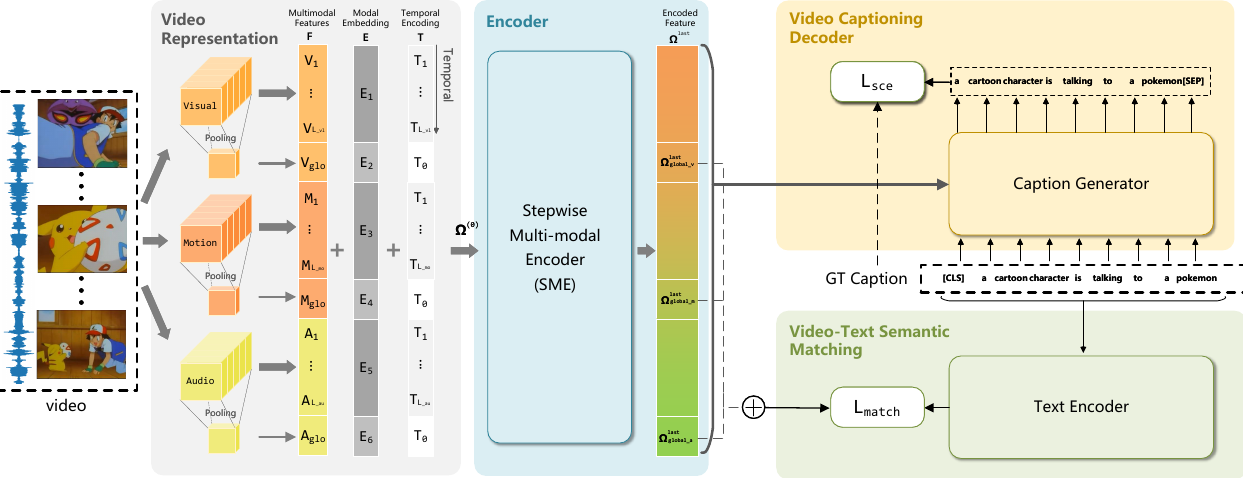
Figure 2. Overview of our multi-task multimodal method. Three modalities are used as an example in this figure. GT is short for Ground Truth. Our design contains four modules: Video Representation, Encoder, Video-Captioning Decoder and Video–Text Semantic Matching. Among them, the first two modules are shared by both tasks, which correspond to the last two modules each. ( (cid:76) refers to element-wise